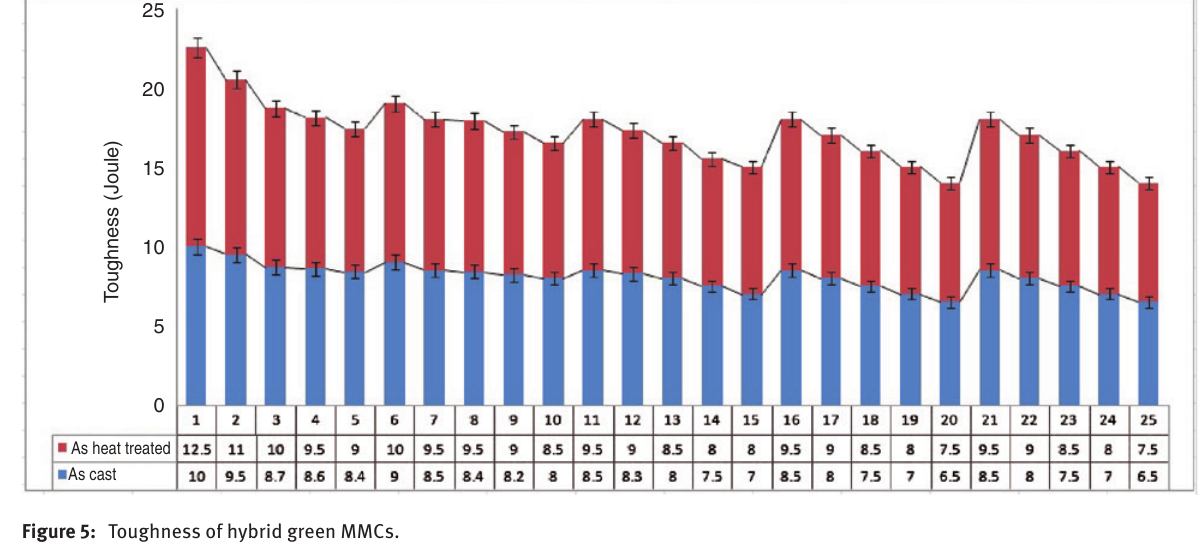
Figure 5: Toughness of hybrid green MMCs.